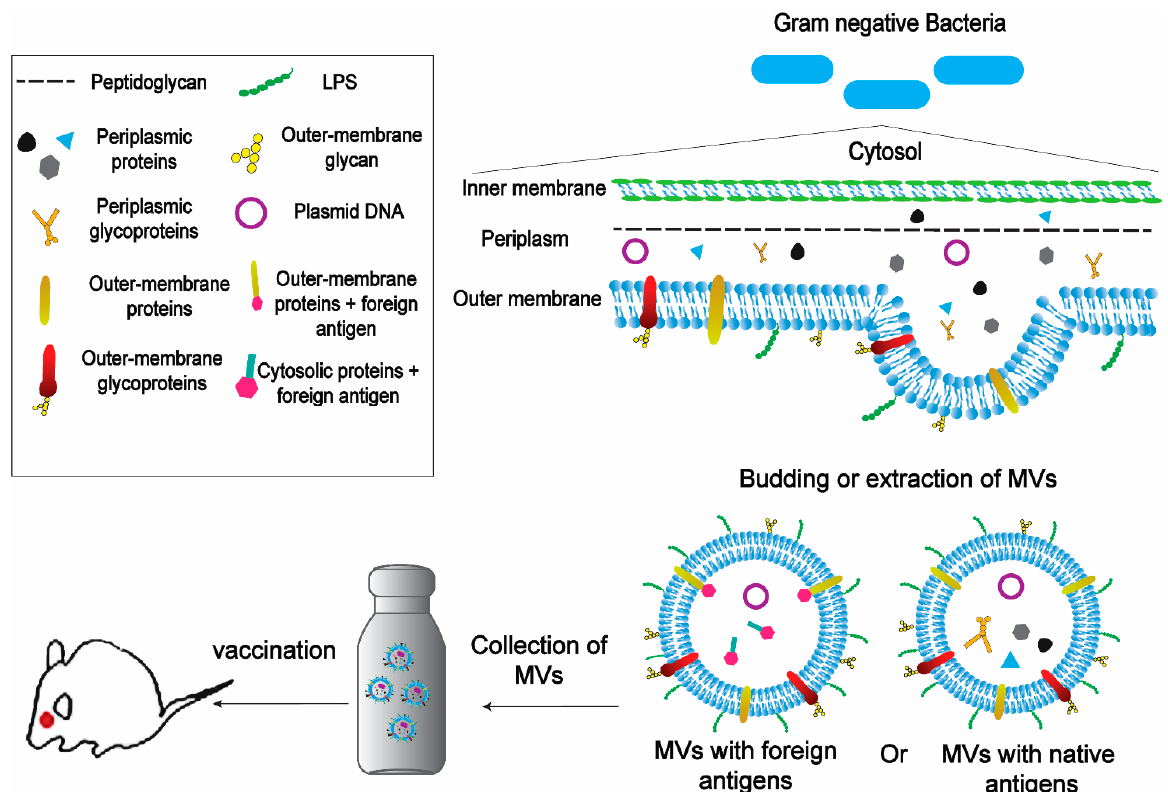
Figure 3. Schematic representation of the application of bacteria-derived MVs in vaccines. MVs can be obtained from Gram-Negative Bacteria naturally by budding or by detergent extraction. MVs can carry native antigens (including proteins, glycans and glycoproteins) or can be engineered to carry foreign antigens fused with outer-membrane proteins or cytosolic proteins. The next step is to isolate and purificate MVs and then collect them in large scale amounts.The MVs’ amount has to be suitable for using in the vaccination process. Then, the MV-based vaccine is performed on animals in non-invasive ways with the possibility of a booster dose.